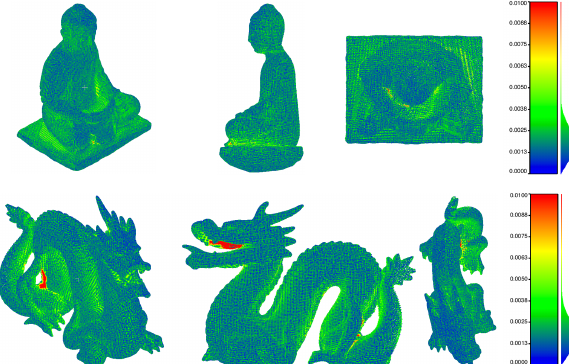
Figure 5. Absolute point-to-point distance encoded by different colors between the reconstructed and reference point cloud for each of the two test objects. All distances greater than 0 . 01 m are marked as gaps in the surface and highlighted in red. In addi- tion to the color map, a histogram showing the distribution of the distance values is